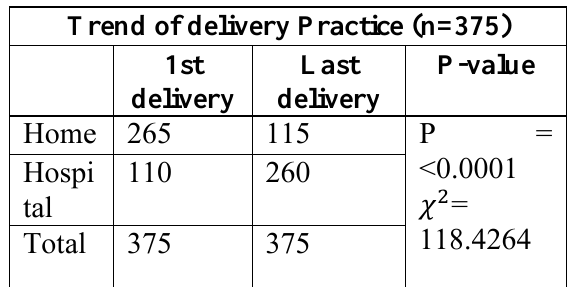
Table 1. Change in Delivery Practices